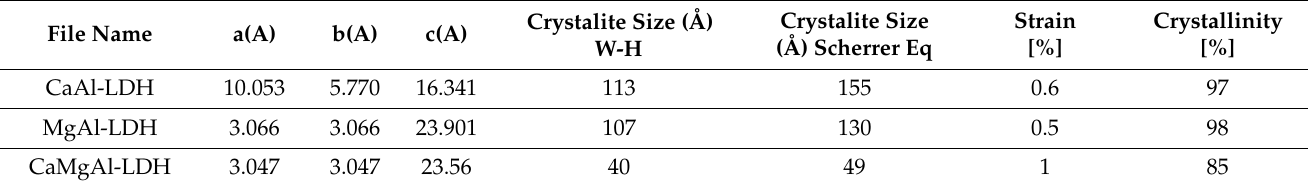
Table 3. Crystallite size from Scherrer method. FWHM: full width at half